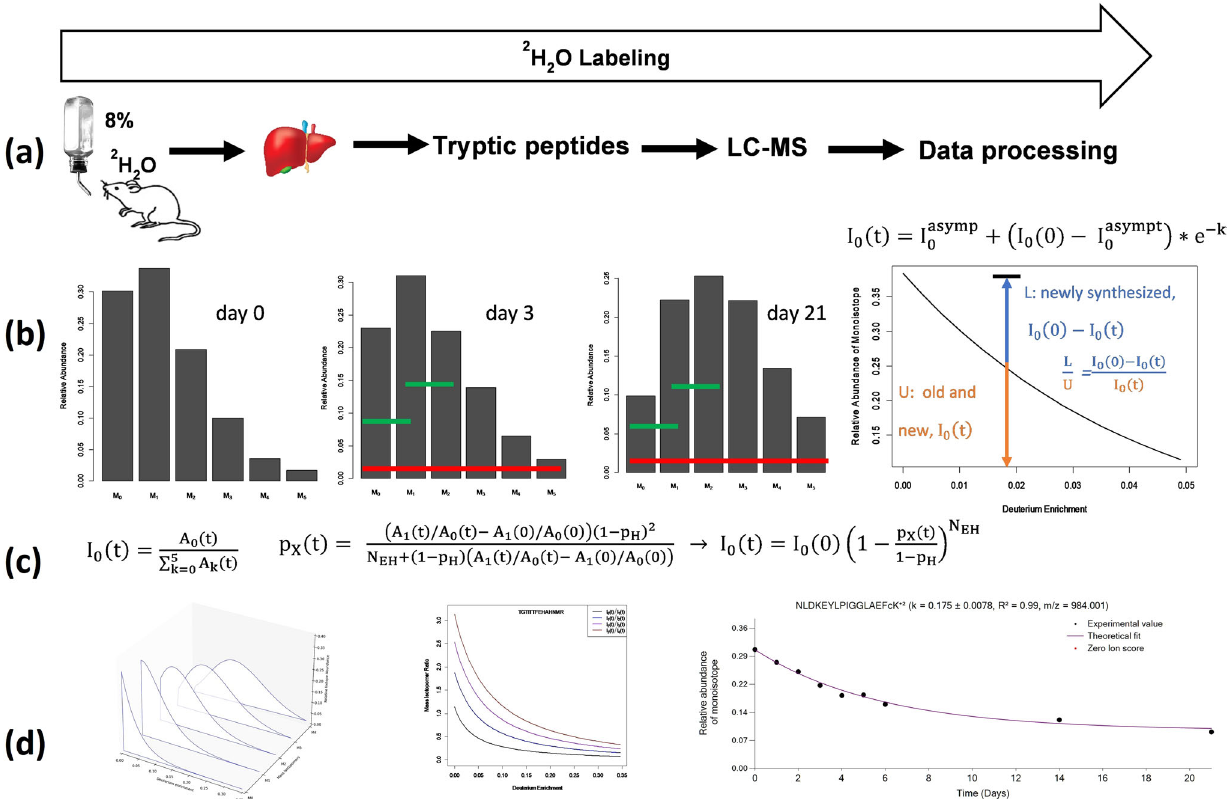
Fig. 1 An approach to estimate protein turnover rates from the abundances of two mass isotopomers. a Experimental and work fl ow of metabolic labeling, LC-MS, and data processing. b Relative abundances of mass isotopomers shifted during the gradual incorporation of deuterium from heavy water. Shown are the isotope pro fi les of peptide, NLDKEYLPIGGLAEFCK, at three labeling durations: 0, 3, and 21 days. The turnover rate is determined from the depletion of the monoisotopic RIA, I 0 (t). c The monoisotopic RIA is traditionally obtained as normalized monoisotopic abundance from the complete isotope pro fi le (red bar). This work determines the monoisotopic RIA from only two mass isotopomers (green bars). At fi rst, the deuterium enrichment of a peptide is determined from two mass isotopomers. Then the deuterium enrichment is used to calculate the monoisotopic RIA. The time course of I 0 (t) is fi t to an exponential decay function to obtain the turnover rate. d The RIAs of the fi rst fi ve mass isotopomers of the peptide as a function of deuterium enrichment. The I k-1 (t)/I k (t) ratios. The experimental values (black circles) and theoretical fi t (purple) for the I 0 (t) of the peptide. I 0 (0) is the monoisotopic RIA of the unlabeled peptide. N EH is the number of hydrogens accessible to deuterium in drinking water. p X (t) is the deuterium enrichment of a peptide at the labeling time point t. A i (t) is the raw (non-normalized) abundance of the i th mass isotopomer measured in LC-MS. L – labeled, Uunlabeled, LC liquid chromatography, MS mass